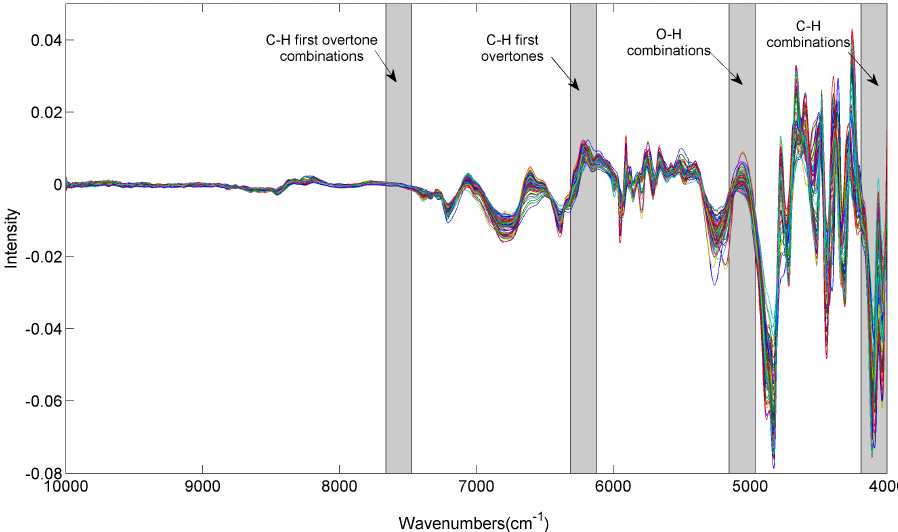
Fig. 2. Pre-processed spectra with SG1st derivative and SNV and variable selection by iPLS (gray shaded area).